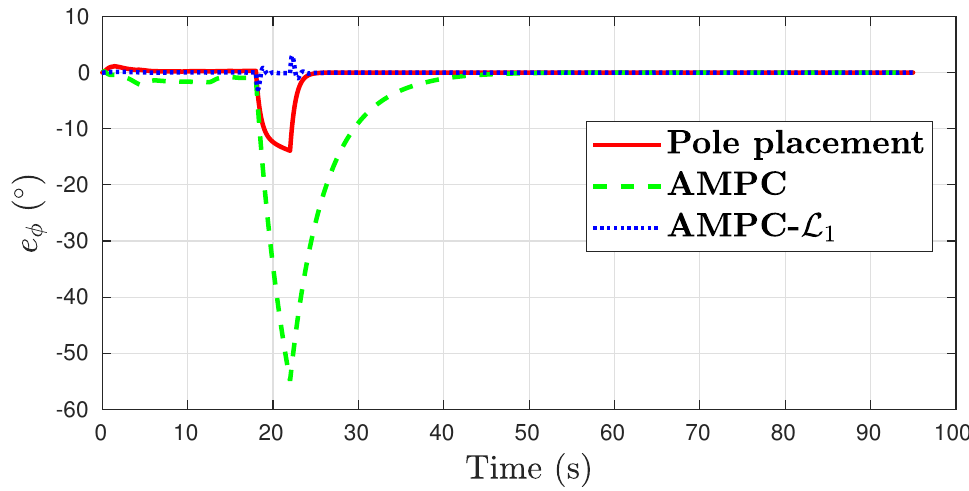
Figure 8. Roll tracking error for aerodynamic uncertainty case. Compared to the nominal case in Figure 5, all controllers produced similar levels of side-slip performance, as shown in Figure 9.